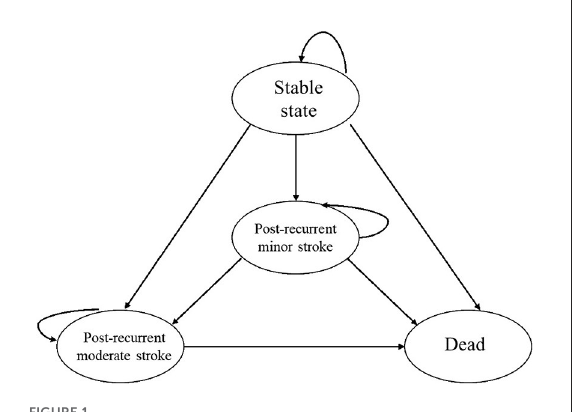
FIGURE1 Possible state transition in the Markov model with a cycle length of 3 months.